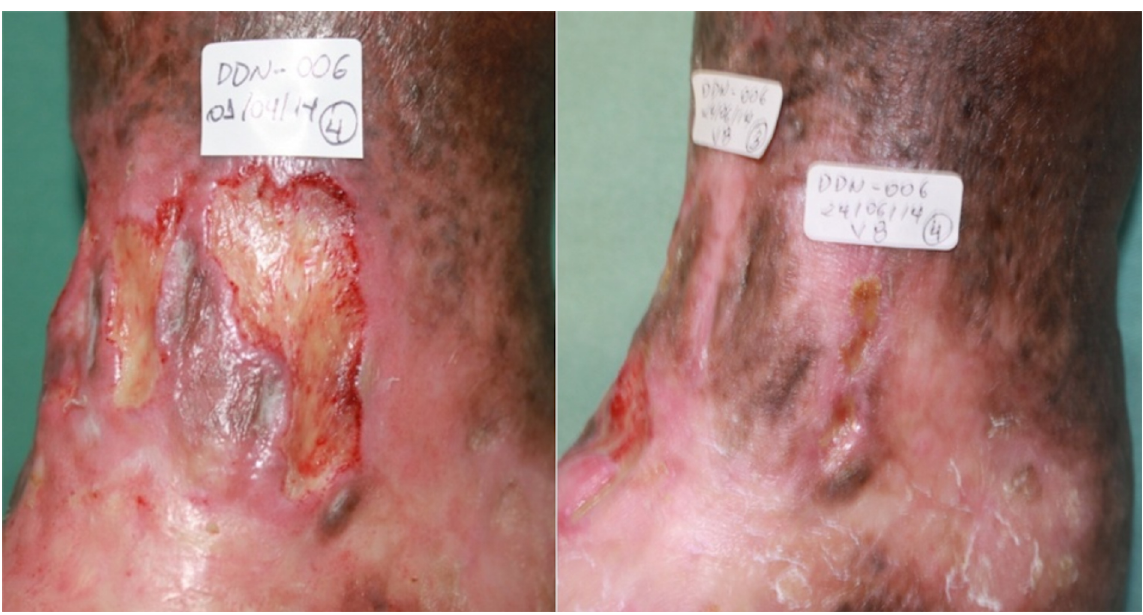
Figure 4. Female patient aged 66 years and carrier of four VUs for one year. Initial ulcerated area was 33.5 cm 2 , area at the final visit was 10.4 cm 2 (two ulcers healed completely).